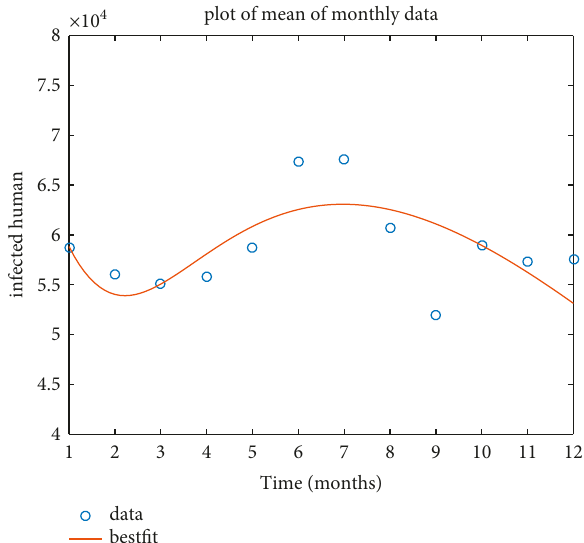
Figure 2: A plot of the mean of the data on confirmed malaria cases from the data obtained from the central regional health directorate of the Ghana health service.